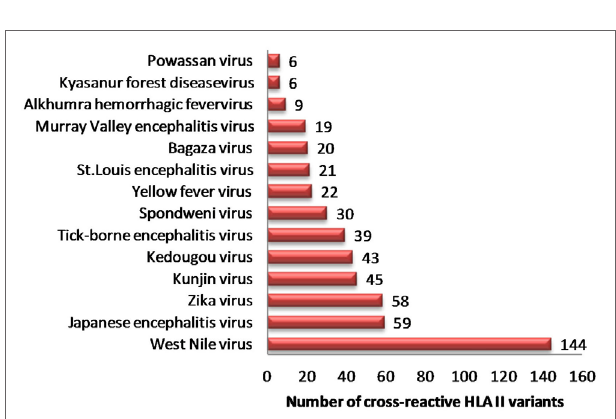
FigUre 2 | Distribution of dengue hemorrhagic fever-associated HLA-II binders from dengue virus cross-reactive to related flaviviruses.